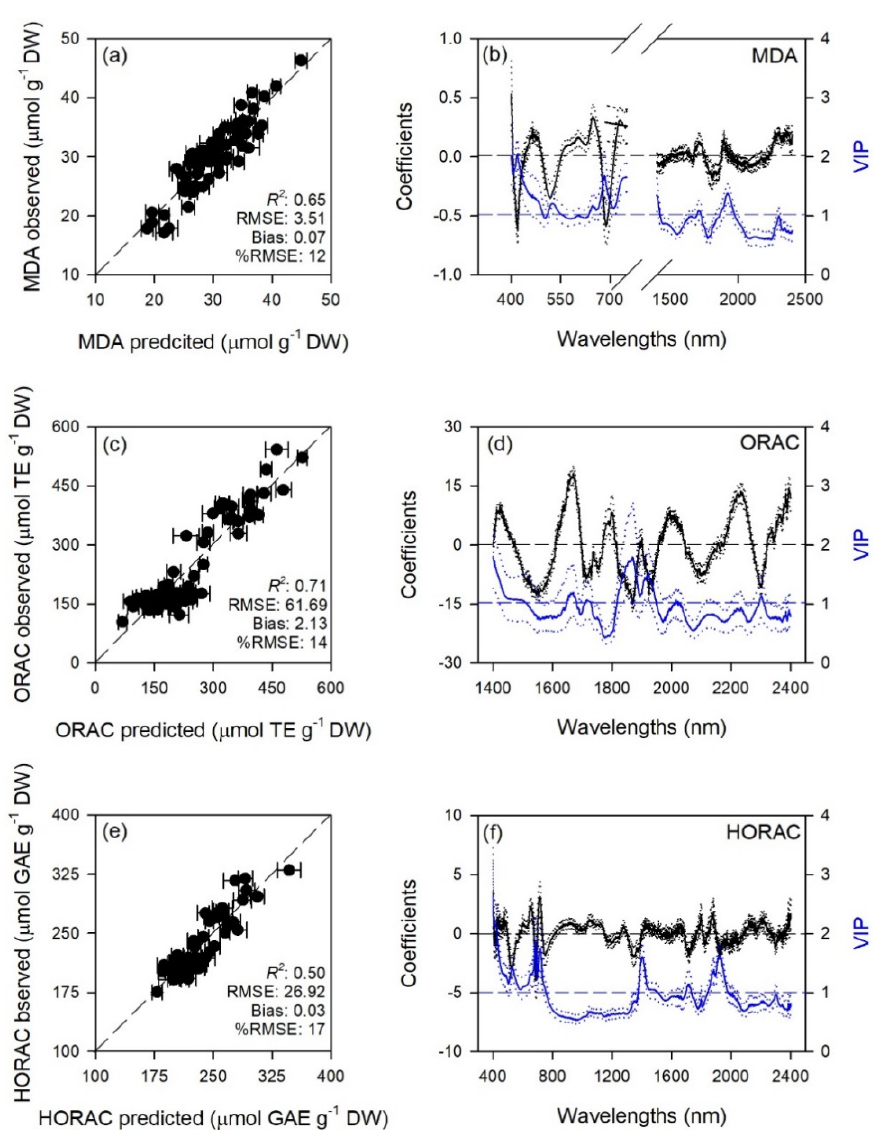
Figure 3. ( a , c , e ) Observed versus partial least squares regression (PLSR)-predicted values of malondialdehyde (MDA), oxygen radical absorption capacity (ORAC), and hydroxyl radical antioxidant capacity (HORAC) in sage; error bars for predicted values represent the standard deviations generated from 500 simulated models; dashed line is 1:1 relationship; model goodness-of-fit ( R 2 ), root mean square error (RMSE), bias and %RMSE for validation data generated using 80% of the data for calibration and 20% for validation are reported. ( b , d , f ) Mean (solid), 5th and 95th percentile (dotted) of standardized coefficients (black), and variable importance for projection values (VIP, blue) by wavelengths for PLSR-models predicting MDA, ORAC, and HORAC in sage.